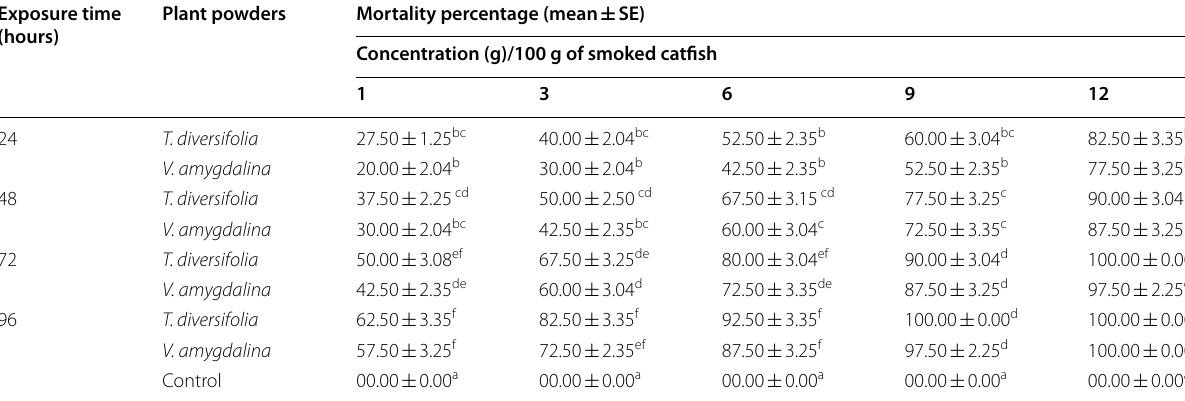
Mean followed by the same letters within the same column are not significantly different ( P > 0.05)